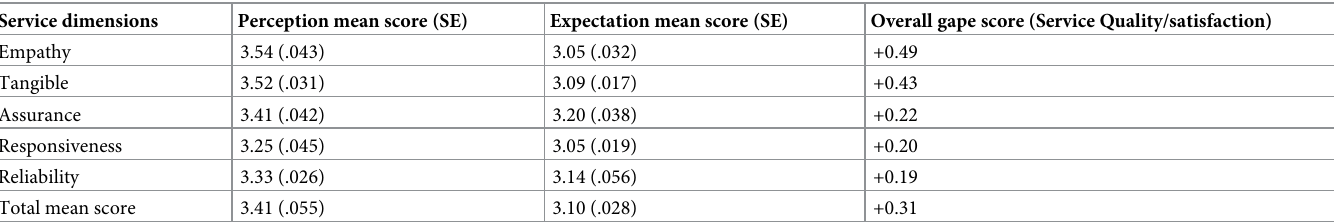
Table 2. The overall level of pregnant women satisfaction with the quality of PMTCT service with all 5-service dimensions. Service